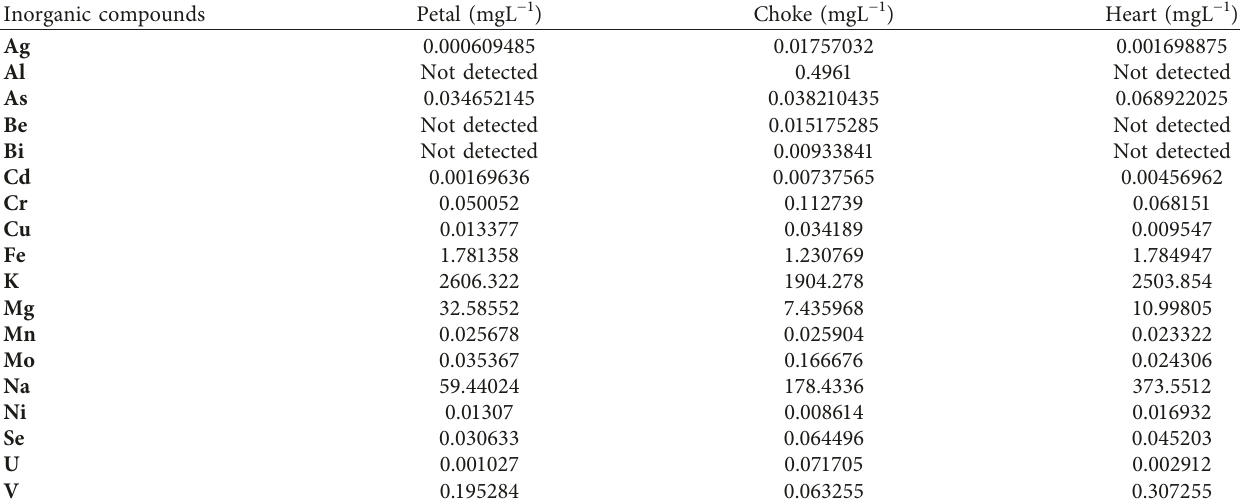
Table 2: Inorganic components detected from the different parts (petal, choke, and heart) of C. scolymus L. head. Inorganic